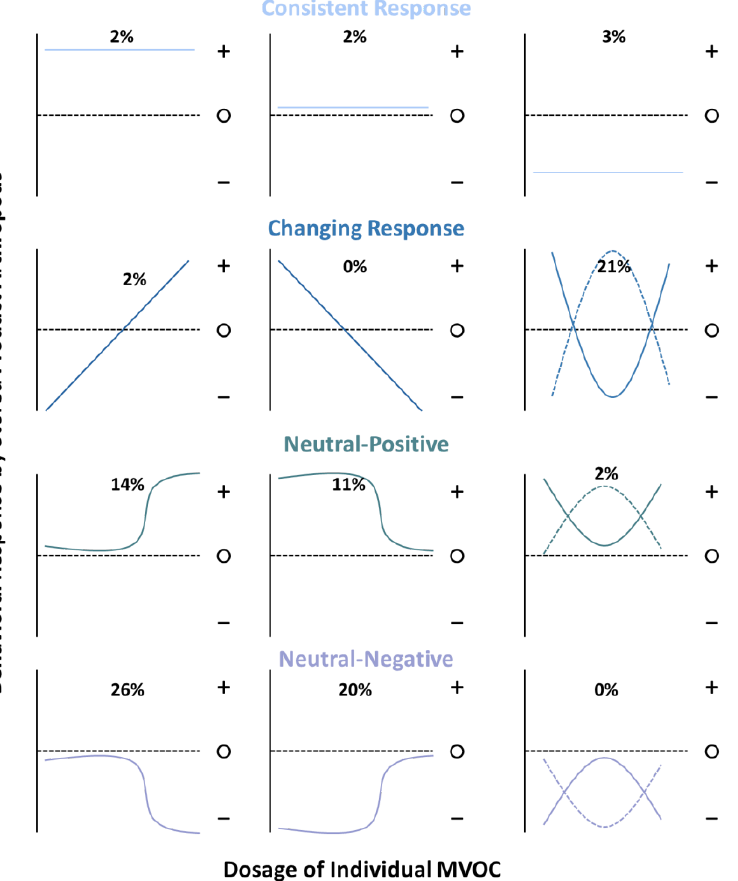
Figure 3. Hypothetical a priori expectations for the behavioral response curves by stored-product arthropods to different dosages of MVOCs and documented responses from published literature. The percentage of cases conforming to each response curve represent a subset ( n = 66) of total documented cases for which there was information about behavioral response at three or more dosages of an MVOC. The most common groups of responses were the changing response, neutral-positive, and neutral-negative, which together comprised 96% of the cases. Abbreviations: +, significant attraction; ○, neutral response (not statistically different from controls); −, significant repellency.